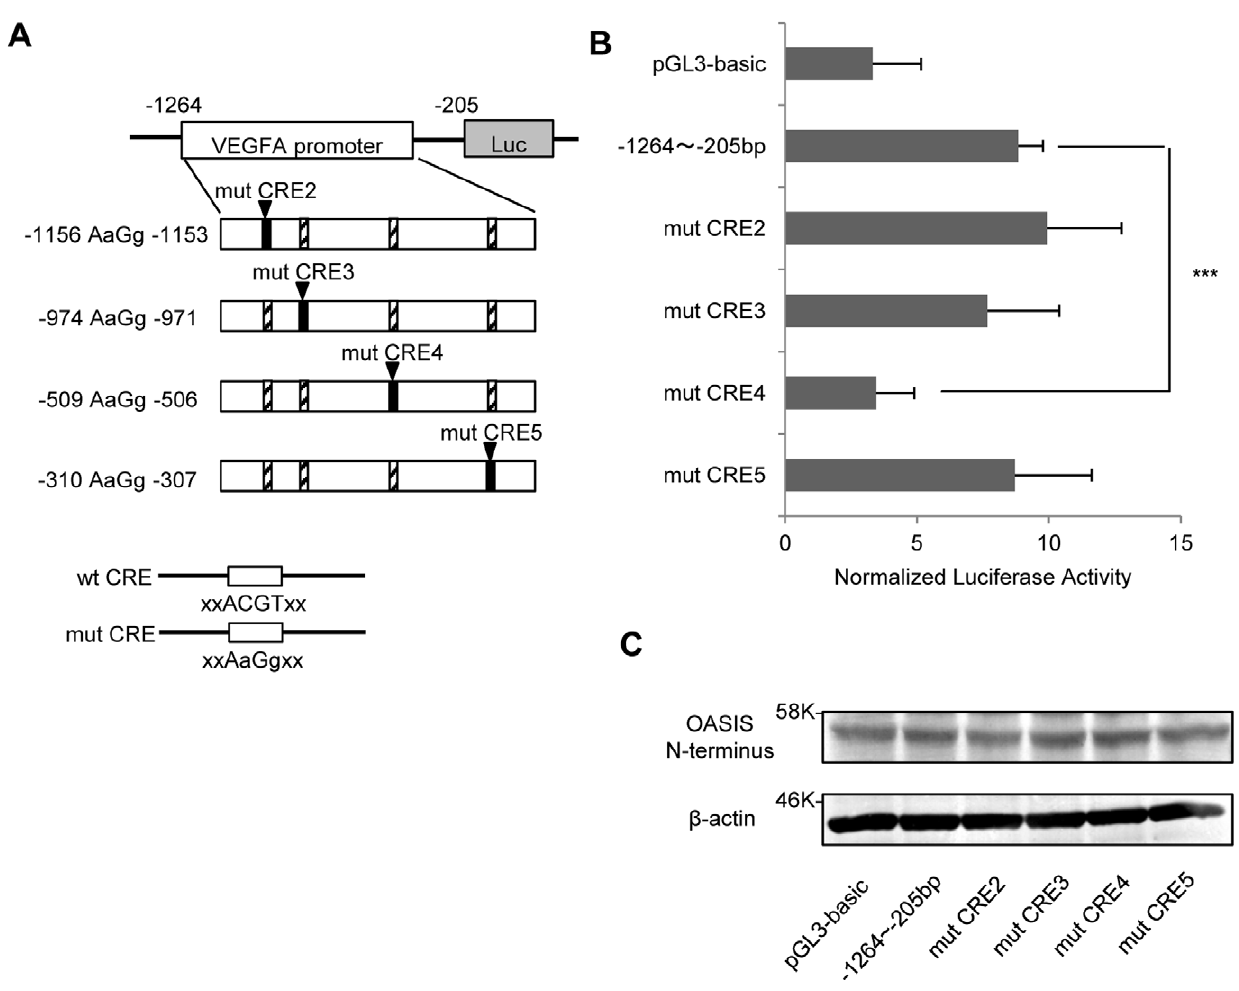
Figure 4. OASIS acts on the CRE-like site at –509 to –506 bp in the VEGFA promoter. (A) The top panel shows schematic diagrams of the mutated reporter constructs. The bottom panel shows schematic representations of the wild-type CRE-like site (containing an ACGT core) and the mutated CRE-like sites (containing an AaGg core). (B) Reporter assays using ARPE-19 cells. Each mutated reporter vector and the OASIS N-terminus expression vector were co-transfected. Reporter assays were performed at 48 h after the transfection. Note that reporter activities significantly decreased in cells transfected with the mutated CRE-like site 4 construct. Data are means 6 SD (n=4). ***p , 0.001, by Student’s t -test. (C) Western blot analysis shows the FLAG-tagged OASIS N-terminus was expressed at equal levels in each